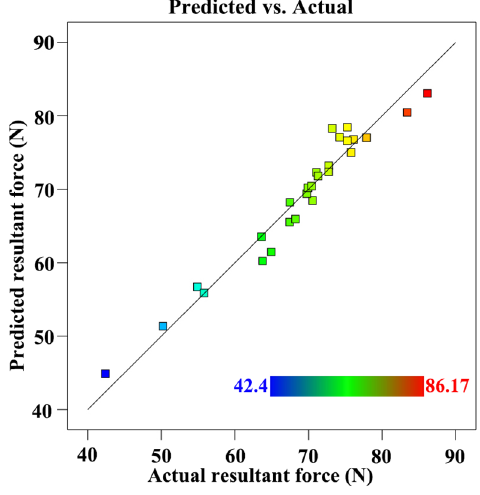
Figure 1. Correlation graph for resultant force.